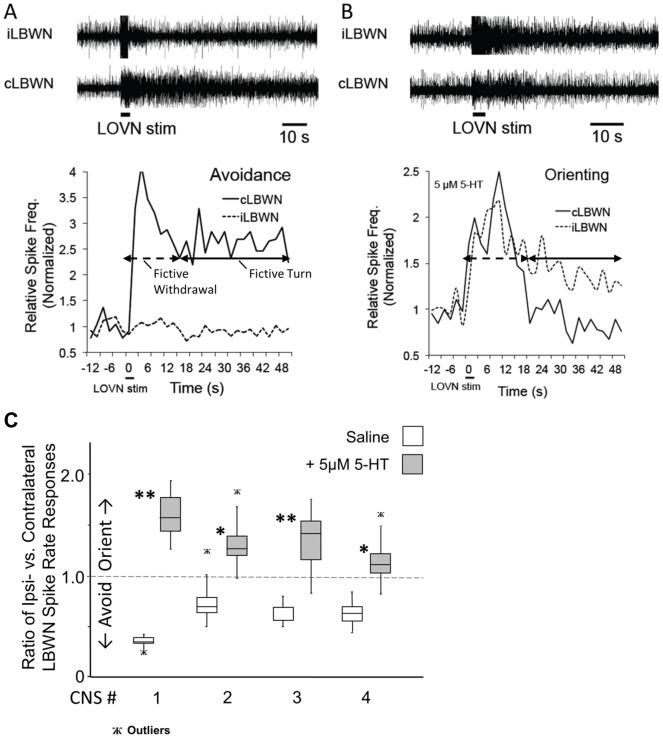
5-HT altered fictive turn preference from avoidance to orienting.Application of 5 µM 5-HT to isolated CNS from each of 4 donors changed fictive turn preference from avoidance to orienting. The figure shows a fictive avoidance turn (A) changed to fictive orienting (B) within 5 minutes following 5-HT addition. Fictive turn direction is shown in differing relative spike rates of the LBWNs following stimulation of the ipsilateral LOVN (short horizontal bar at bottom) [9]. Fictive turns (solid double arrows) are measured following transient fictive withdrawal responses (dashed double arrows). C. Box and whiskers plot of ratios of spike frequencies for the LBWNs calculated across bins to assess orienting vs. avoidance turns in control vs. 5-HT conditions. Variations across ratio medians were significant (Kruskal–Wallis ANOVA; p<0.0001). Ratios of spike frequencies in 5-HT were significantly different from controls (two-tailed Dunn's Multiple Comparisons Test; *p<0.01; **p<0.001; Table 1).